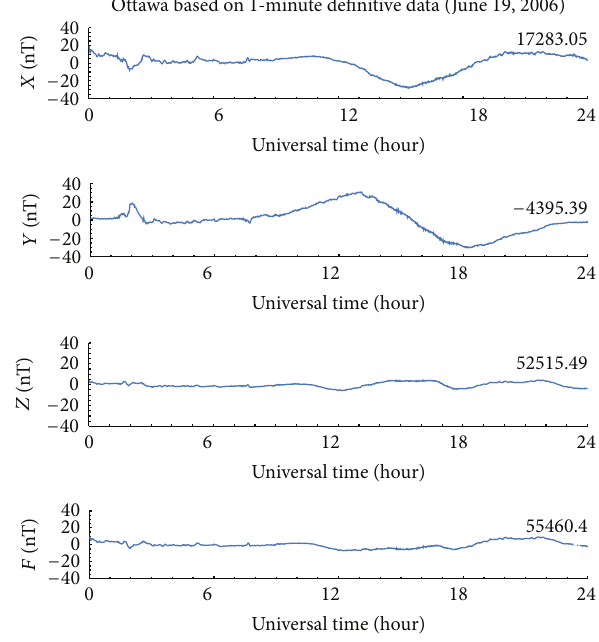
Figure 3: The magnetogram of a day in OTT.